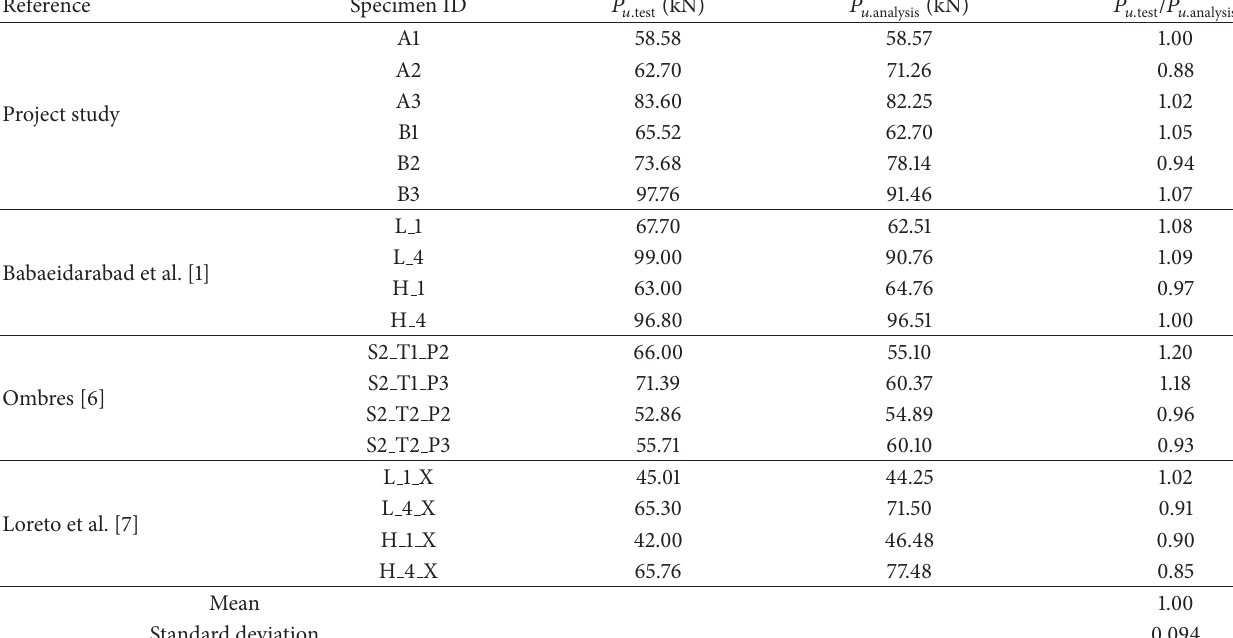
Table 8: Comparisons between test results and analytical results.